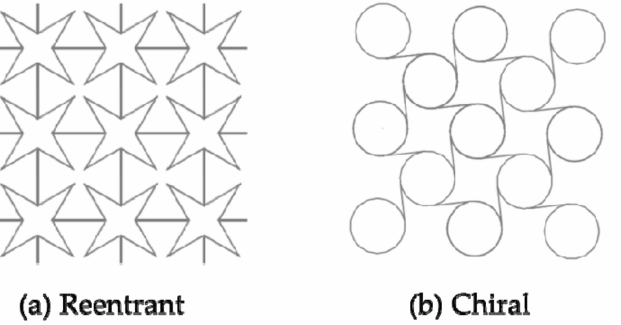
Figure 15. Auxetic structures of application stents [115]: ( a ) Reentrant; ( b )